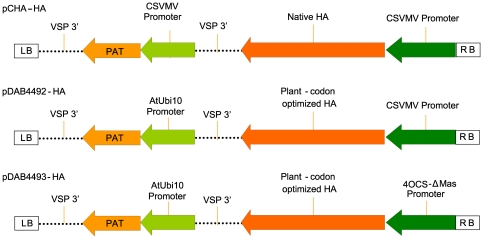
Constructs used to drive expression of HA gene in N. tabacum LAFC 53.CsVMV = the cassava vein mosaic virus promoter. 4OCS-ΔMas = a chimeric synthetic promoter. Native HA = the coding region of haemagglutinin from the turkey Wisconsin HA5 AIV strain. Plant-codon optimised HA = the modified haemagglutinin coding sequence based on plant codon usage frequency. LB and RB represent the left and right T-DNA borders respectively. VSP 3′ = the terminator of the soybean vegetative storage protein. PAT = the phosphinothricin acetyl transferase gene.